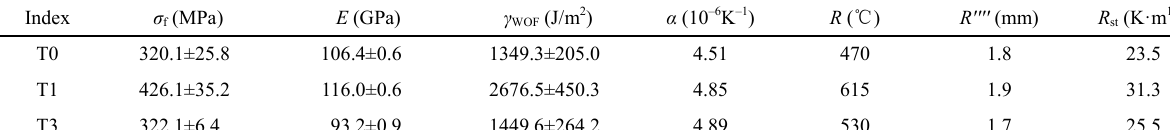
Table 1 Mechanical properties and thermal shock related parameters